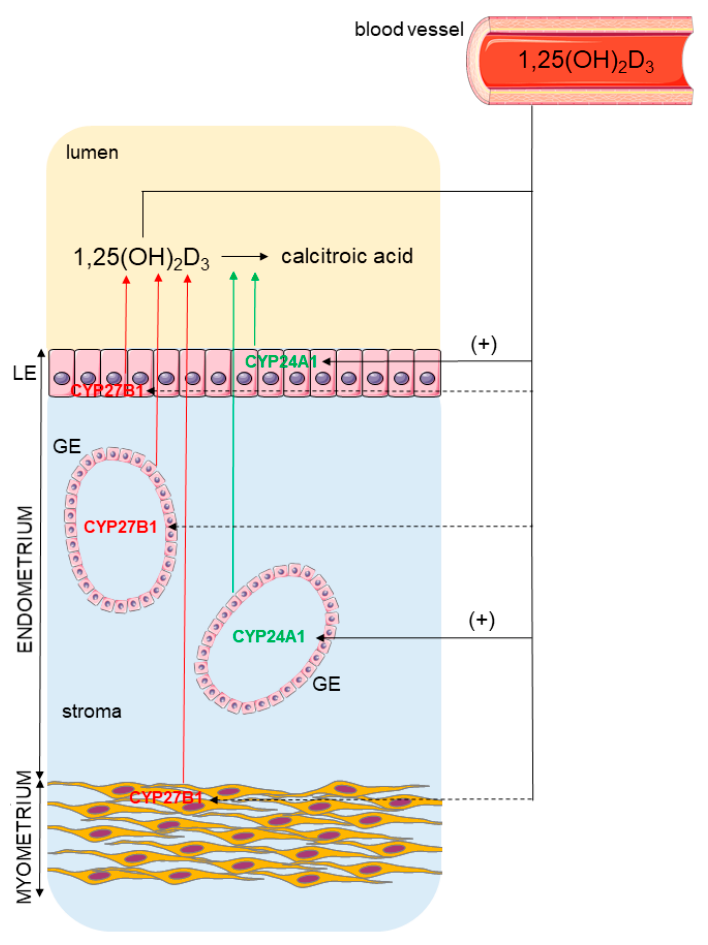
Figure 7. The pattern of CYP27B1 and CYP24A1 distribution in the porcine uterus and the proposed effect of 1,25(OH) 2 D 3 on their abundance. The solid line indicates a positive effect (+), while the dashed line (---) indicates a lack of effect.